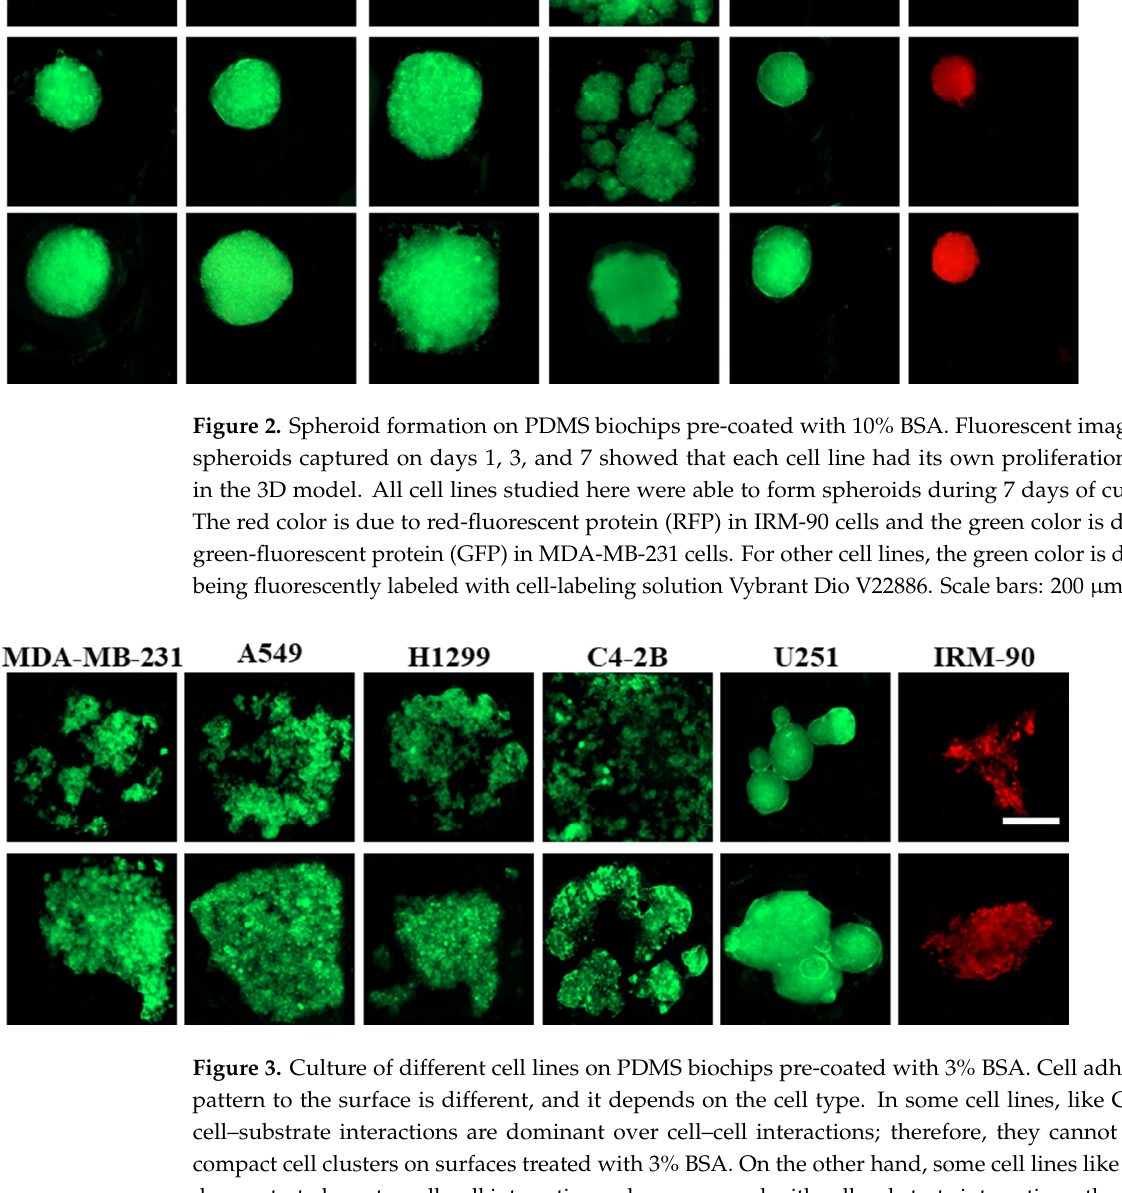
Figure 3. Culture of different cell lines on PDMS biochips pre-coated with 3% BSA. Cell adhesion pattern to the surface is different, and it depends on the cell type. In some cell lines, like C4-2B, cell– substrate interactions are dominant over cell–cell interactions; therefore, they cannot form compact cell clusters on surfaces treated with 3% BSA. On the other hand, some cell lines like U251 demon- strated greater cell–cell interactions when compared with cell–substrate interactions; therefore, this leads to the formation of more compact cell clusters. The red color is due to red-fluorescent protein